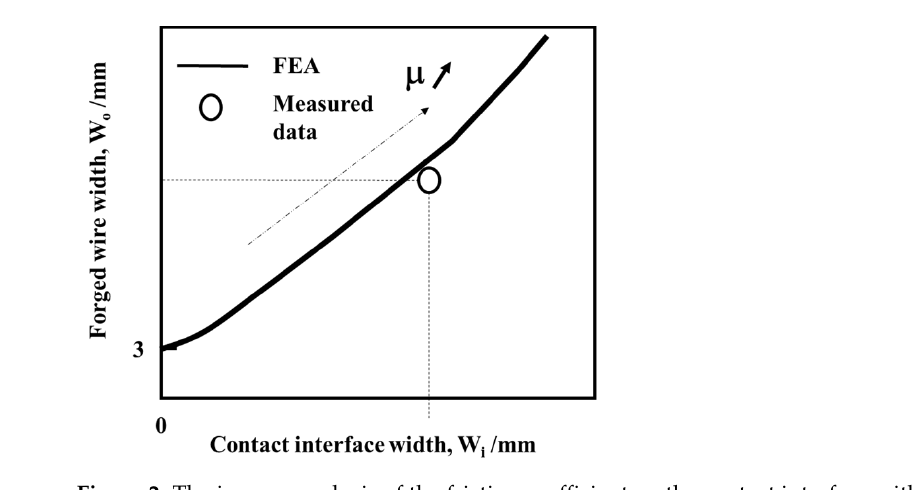
Figure 2. The inverse analysis of the friction coefficient on the contact interface with the aid of the finite element analysis.